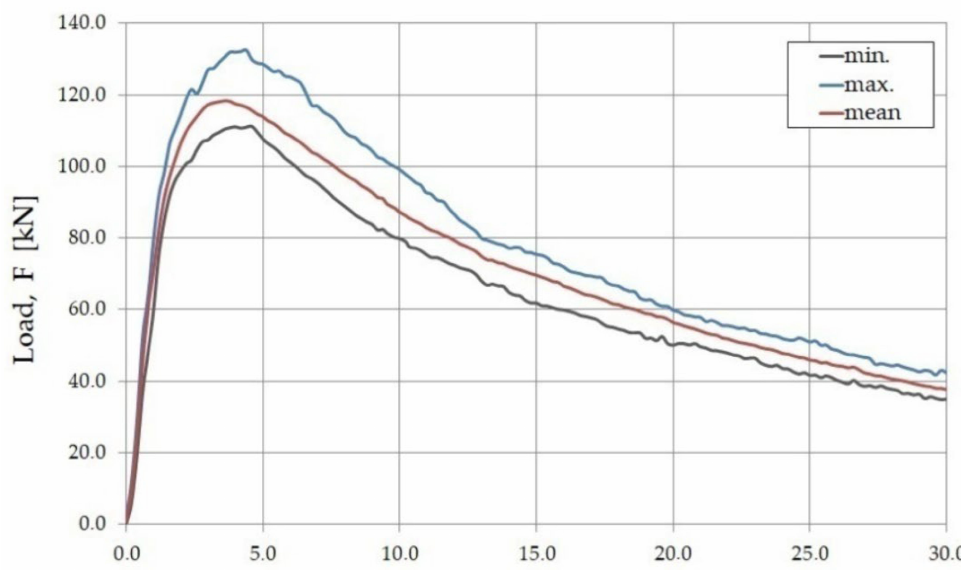
Figure 8. The load–deflection relation (F– δ p.exp ) for bent slabs made from the fiber composite used in the study.